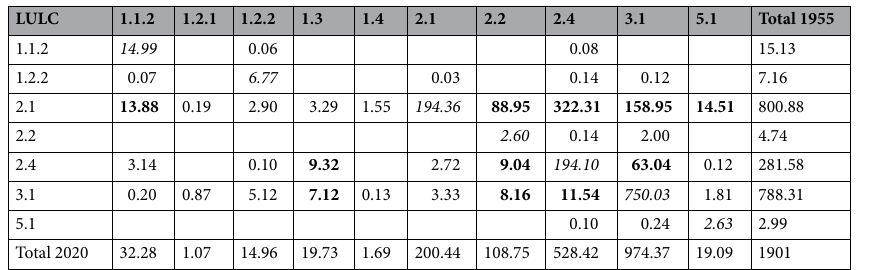
Table 7. LULC change matrix between 1955 and 2020 in the Aksu region (areas in hectares). Significant values are in [bold, italics].